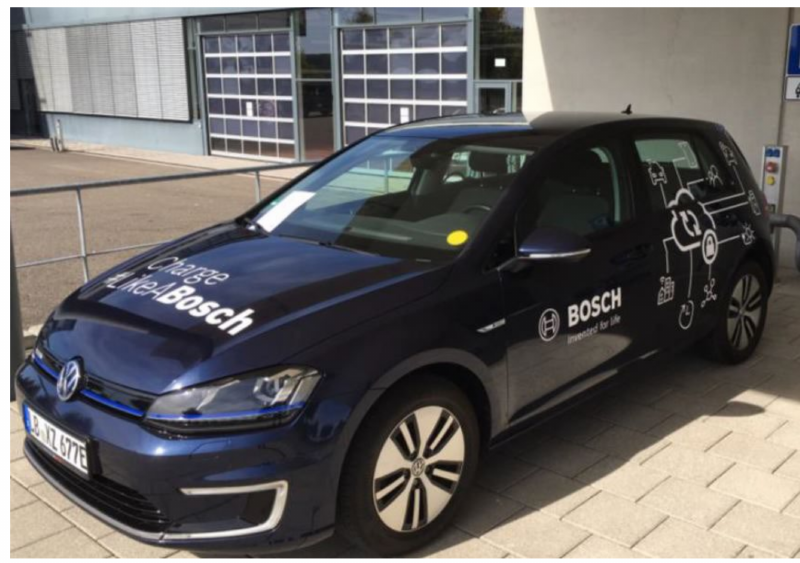
Figure 3. Passenger car to test the V2G using Combo CCS Type 2.